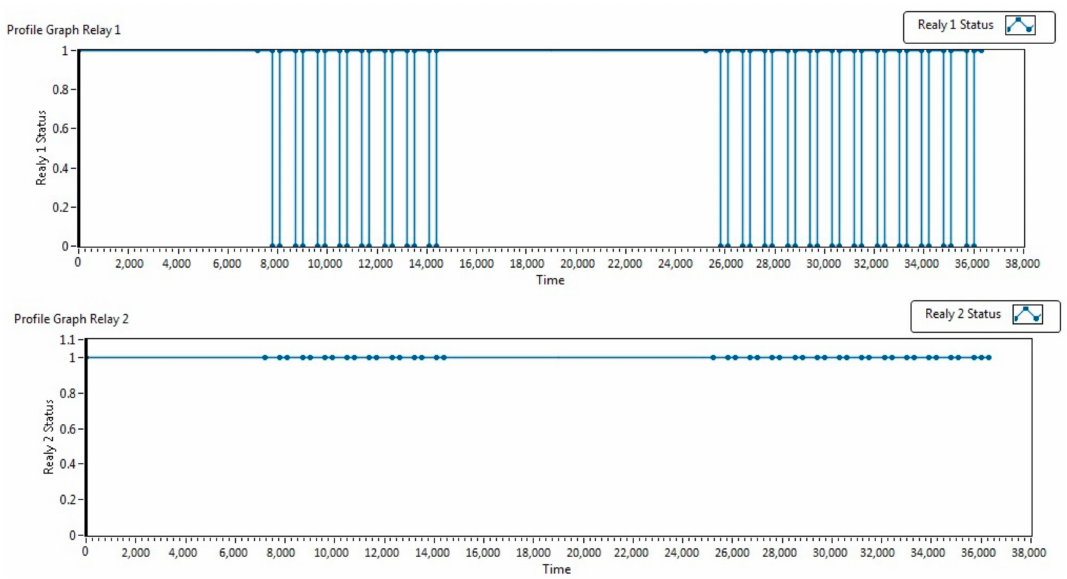
Figure 7. Front panel interface for remote control of the plugs—relay status